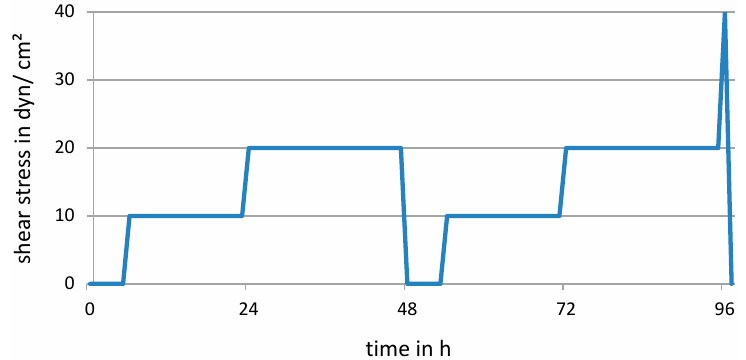
Figure 7. Perfusion protocol of the conditioned TEVGs. After fibroblast (FB) seeding ( t = 0 h) the shear stress was gradually raised to 10 dyn/cm 2 ( t = 6 h) and 20 dyn/cm 2 ( t = 24 h). Erythrocytes (ECs) were seeded at t = 48 h and were similarly perfused to FBs. The pulsation starts at t = 24 h, stops after ECs seeding and restarts at t = 72 h. After 96 h the shear stress was finally raised up to 40 dyn/cm 2 for 1